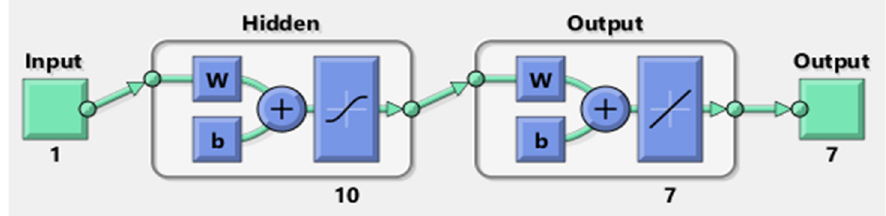
Figure 3. Proposed ANNs-LMB to solve the nonlinear COVID-19 spreading model with a single input layer, a single hidden layer with 10 number of neurons, and a single output layer with 7 outputs. Table 1. ANNs-LMB to solve nonlinear the COVID-19 spreading model.